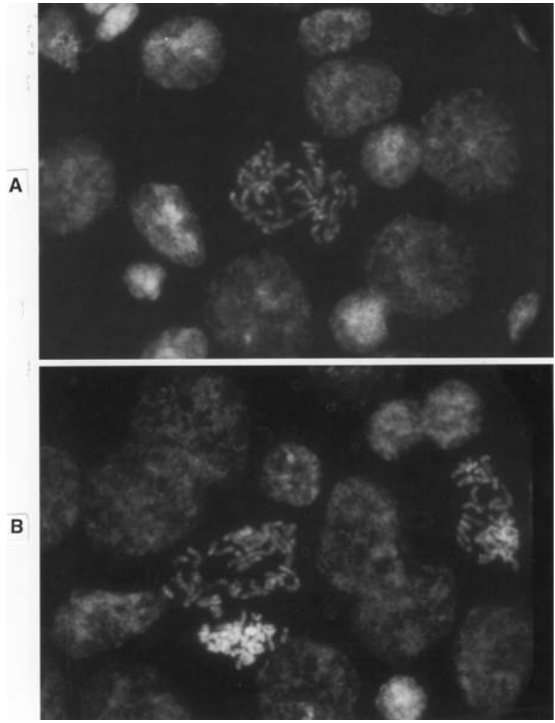
Figure 3 - Metaphases of female Trigona branneri after staining with DA/CMA 3 .